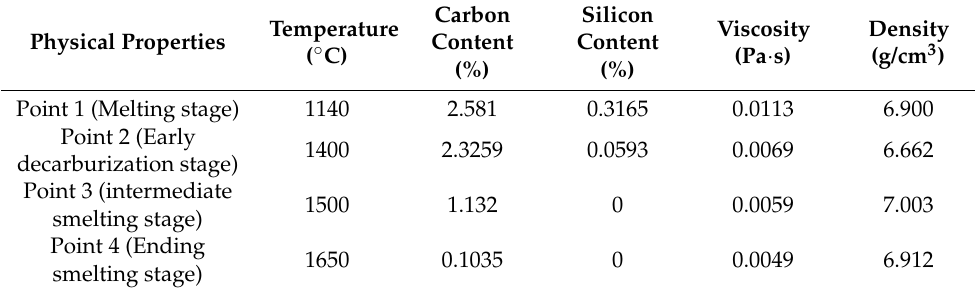
Table 1. Relevant parameters of characteristic points in different smelting